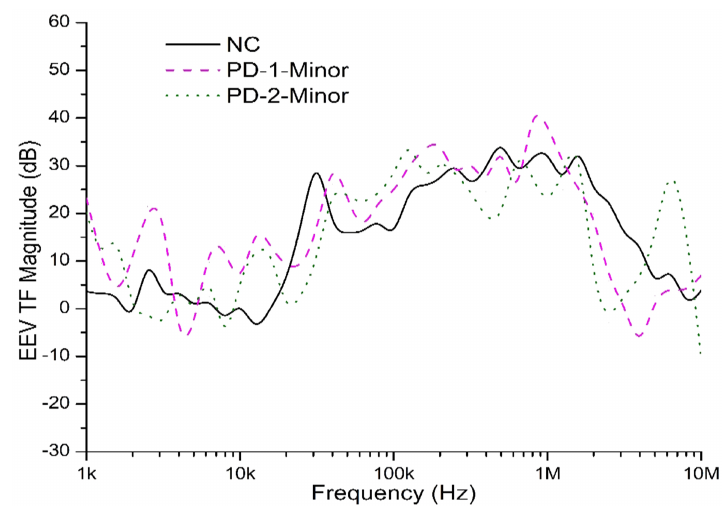
Figure 8. Comparison of EEV TF plots for the diagnosis of sources of PDs across minor insulation: Normal case (vs) PD-1-minor (vs) PD-2-minor.